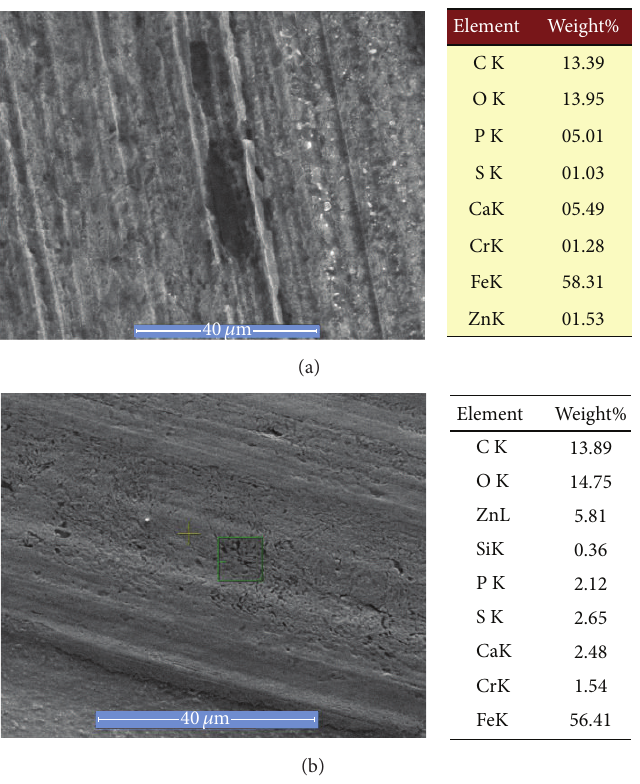
Figure 6: Elemental composition of the ball surfaces run on (a) Oil A and (b) Oil A1.